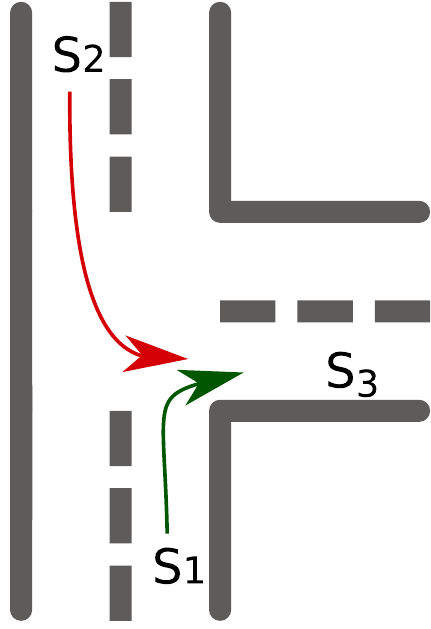
Figure 3. T-intersection with give way rule, as depicted in the